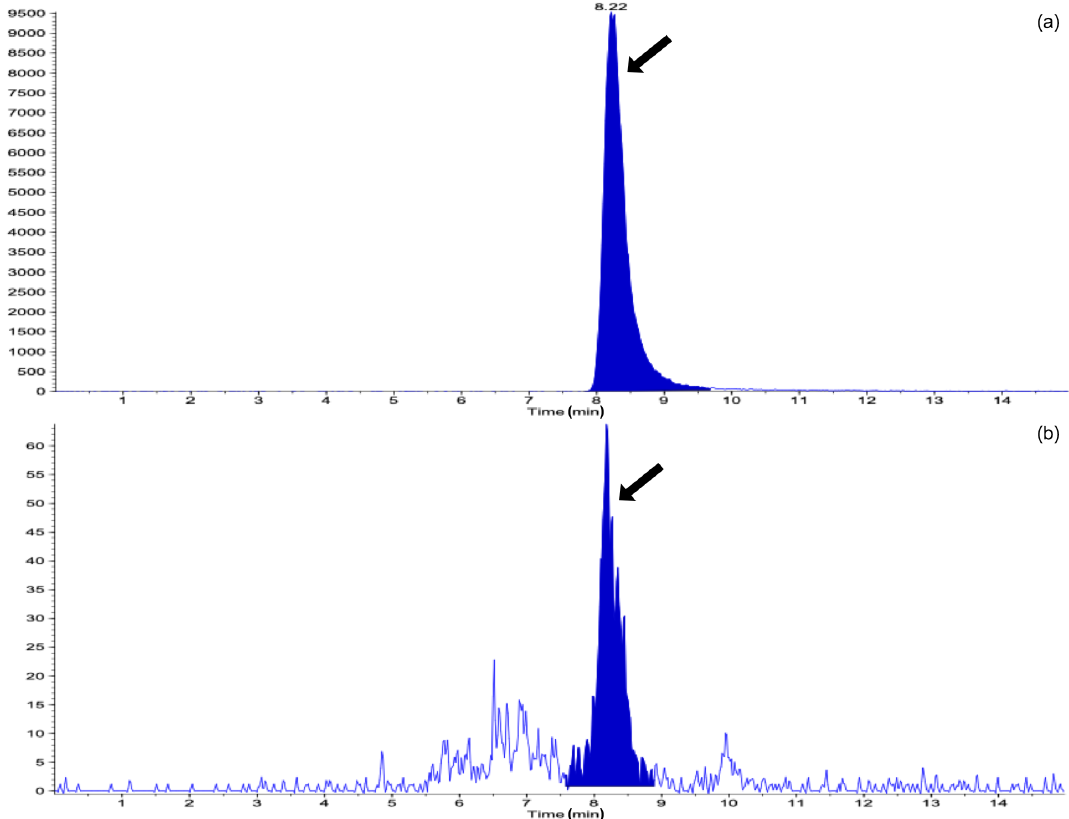
Figure 2. Representative liquid chromatography–tandem mass spectrometry chromatograms for (a) the sterigmatocystin (STC) standard (1ngmL − 1 ). (b) A clear peak of STC contamination in the urine sample (arrow). The horizontal axis represents time